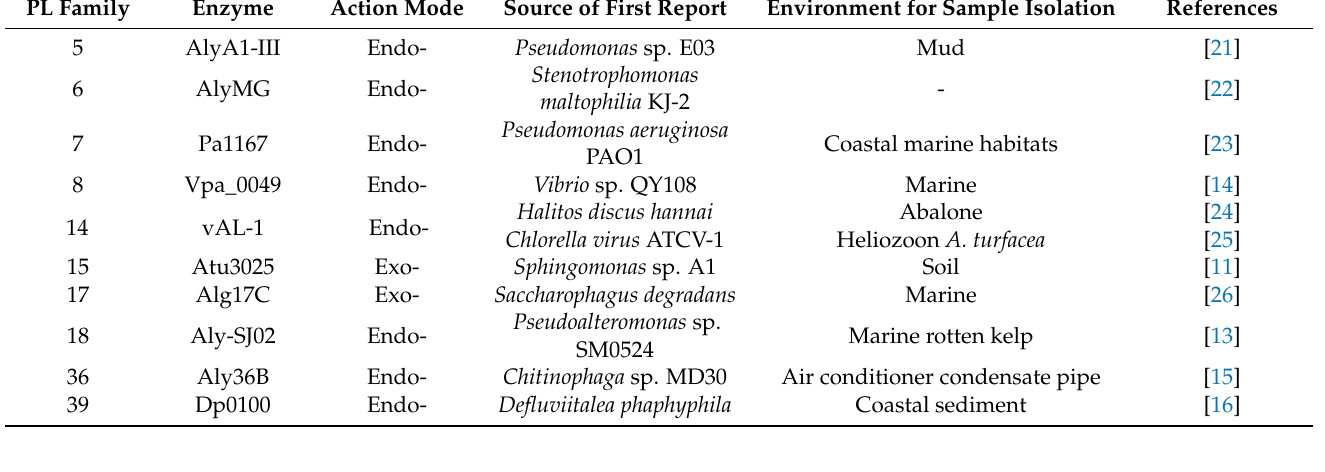
Table 3. Summary of different types of alginate lyases in the PL families.